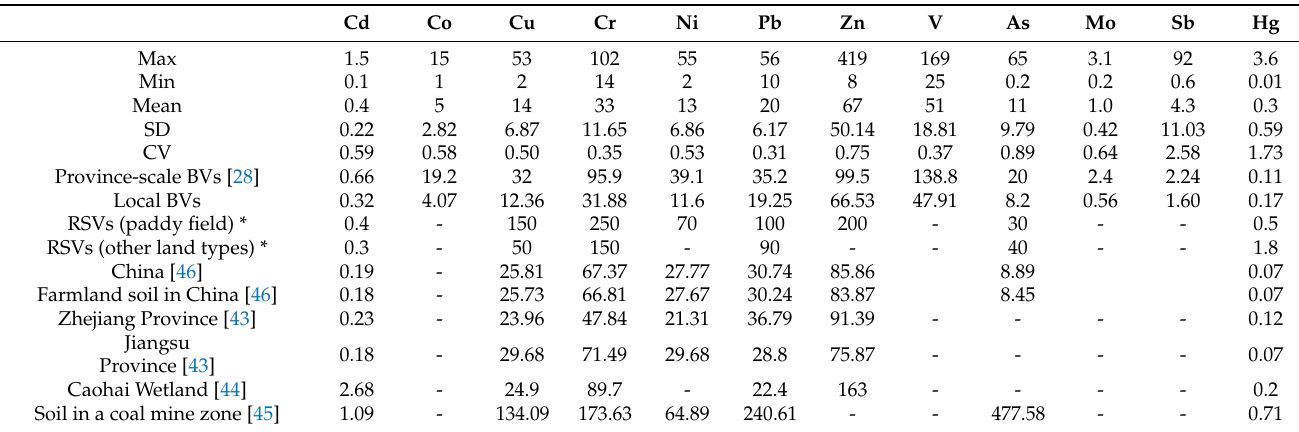
Table 1. Total contents of potentially toxic elements in soils from Caidi River Watershed and values from other stud- ies